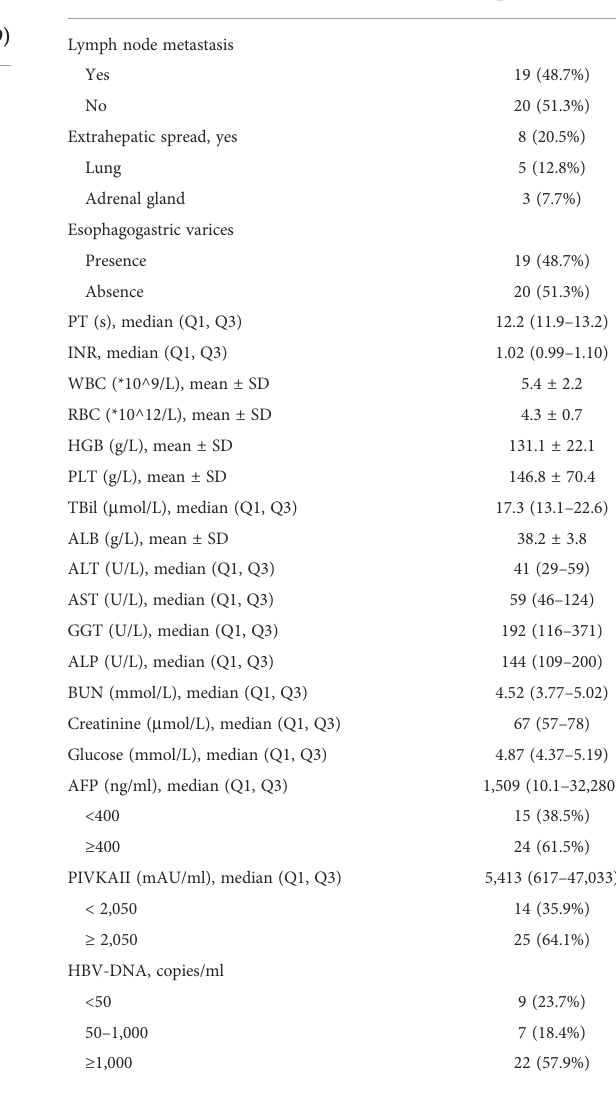
TABLE 1 Baseline demographic and clinical characteristics of unresectable hepatocellular carcinoma (HCC) patients with portal vein tumor thrombus